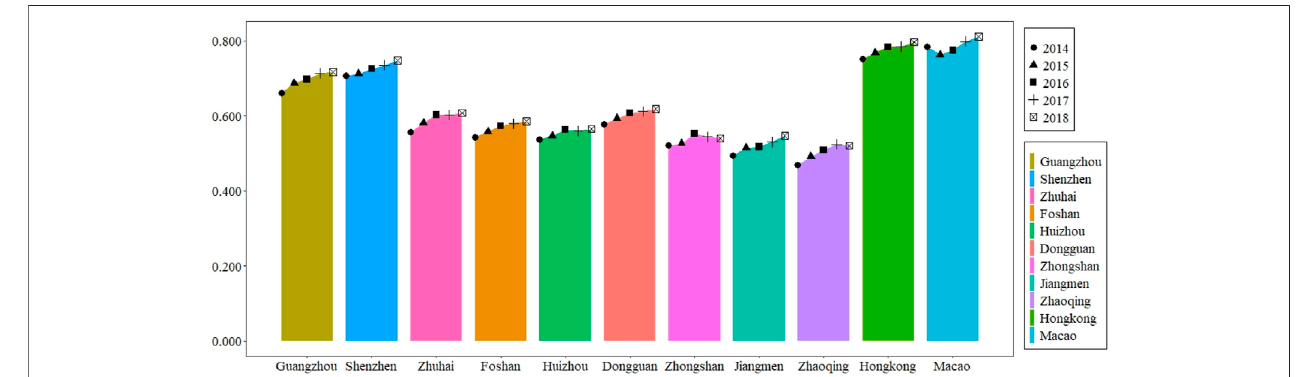
FIGURE 8 | Coupling coordination degree of compound ecosystem in the